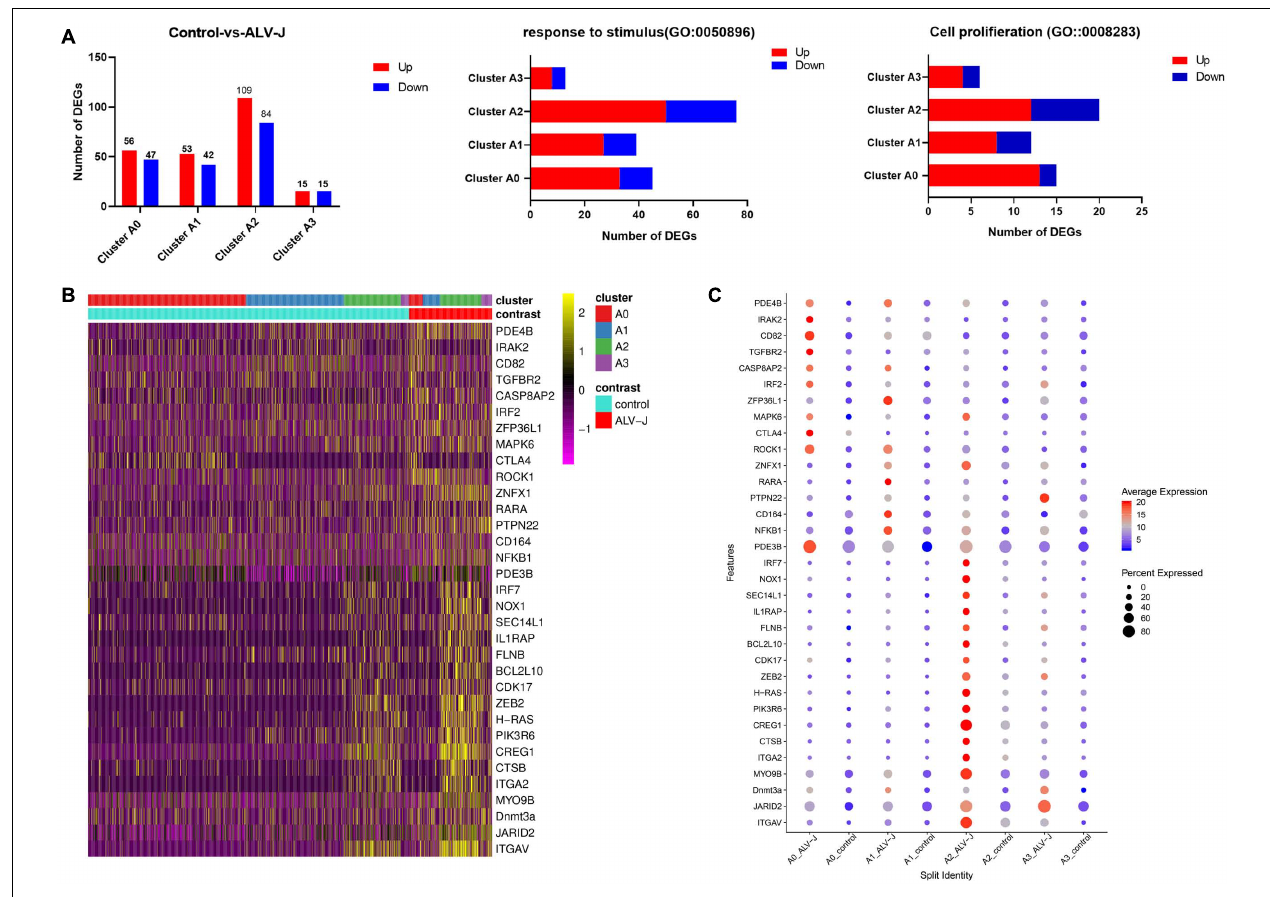
FIGURE 6 | Landscape of immune-related gene expression in clusters A0–A3 of the ALV-J infected and control samples. (A) Histogram shows all the up-regulated (red) and down-regulated (green) DEGs, and the number of DEGs involved in GO terms “response to stimulus” and “cell proliferation” in cells of clusters A0–A3 from ALV-J infected chicken compared to those from the control. (B) Heatmap shows the normalized expression ( Z -score) of all immune-related DEGs in cells of clusters A0–A3 from the ALV-J infected sample compared with the control one. (C) Dot plot representing DEGs expressed in clusters A0–A3 from the ALV-J infected sample is compared with those from the control sample. The intensity represents the expression level, while the size of the dots represents the proportion of cells expressing each